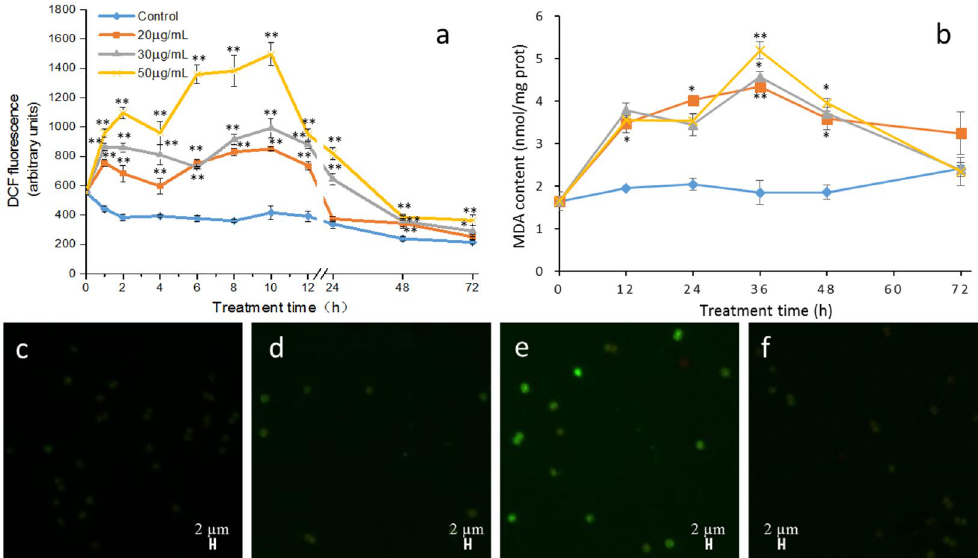
Figure 6. Effect of PG on ROS and MDA contents of M. aeruginosa. Algal cells treated with 20 µ g/mL, 30 µ g/mL or 50 µ g/mL of PG were harvested for ROS levels ( a ) and MDA content ( b ) measurements. ( c – f ): fluorescence microscope images of intracellular ROS fluorescence intensity in cells treated with 30 µ g/mL PG for 0, 2, 10 and 24 h. Values are means ± SD (n = 3). * ( p < 0.05) and ** ( p < 0.01) represent significant differences compared to the control